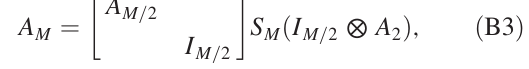
TABLE I. Comparison of different QImRs for an image F ¼ ð F and n ¼ 2 m ).